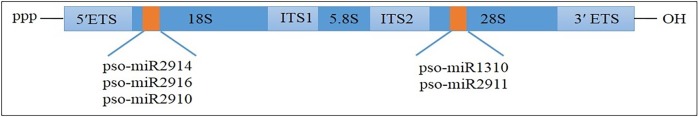
Schematic representations of cluster miRNAs in pre-rRNA of P. somniferum L. and P. bracteatum L.ETS: External Transcribed Spacer, ITS: Internal Transcribed Spacer.